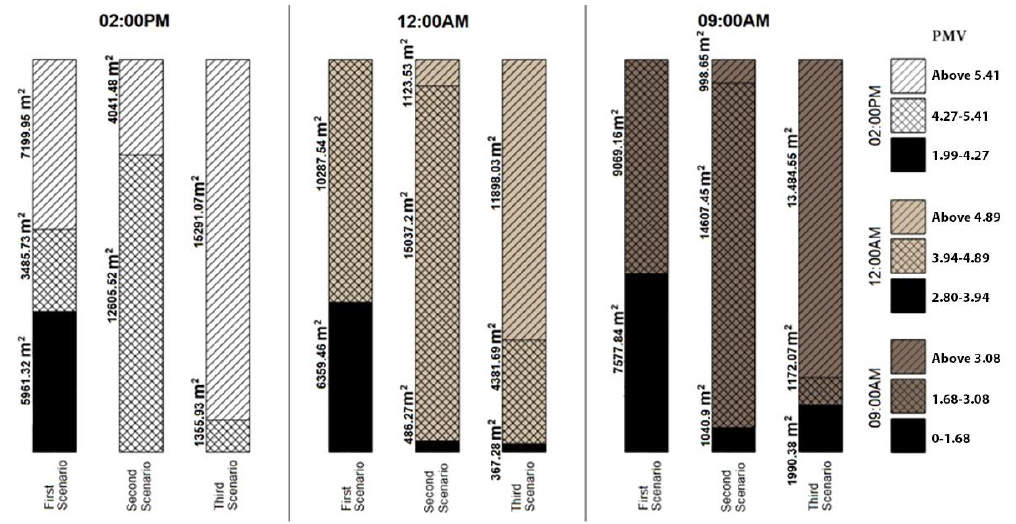
Figure 9. Comparison of the area of the urban environment concerning the predicted mean vote (PMV) classification.